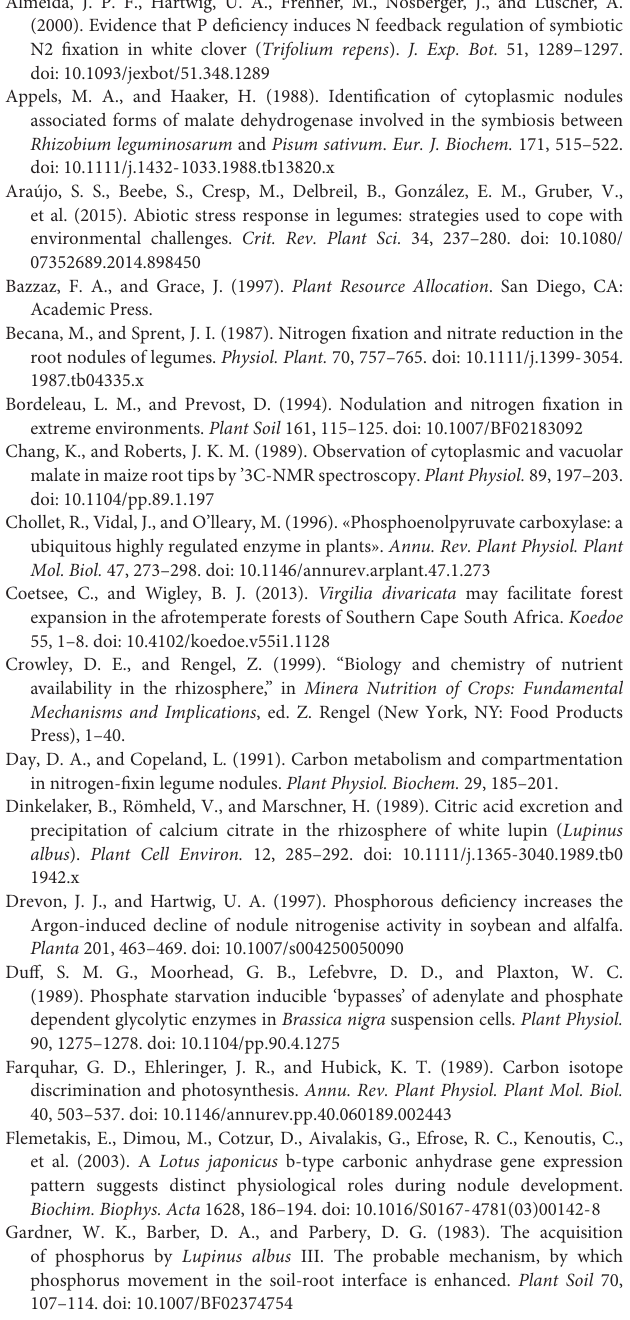
FIGURE S4 | A section of the 13 C spectra of (a) nodules after 1 h, (b) nodules after 2 h grown under low phosphate (5 µ M P) conditions of V. divaricata. FIGURE S5 | A sample of the full 13 C spectra of roots after 1 h, from plants grown under high phosphate (500 µ M P) conditions of V. divaricata. FIGURE S6 | A sample of the full 13 C spectra of nodules after 1 h, from plants grown under high phosphate (500 µ M P) conditions of V.